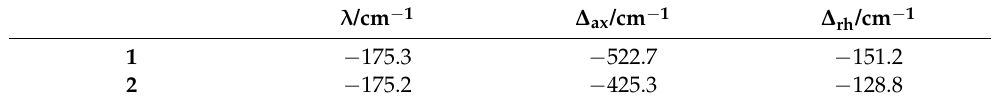
Table 2. Calculated magnetic parameters for model molecules 1 and 2